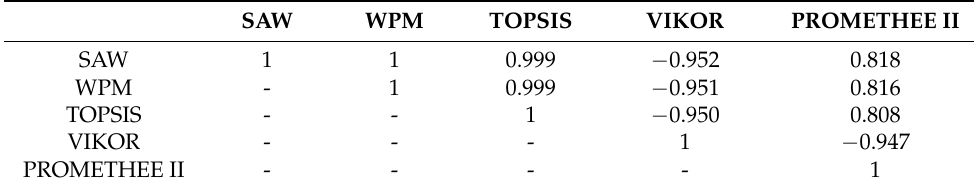
Table 8. The Pearson correlation coefficient.